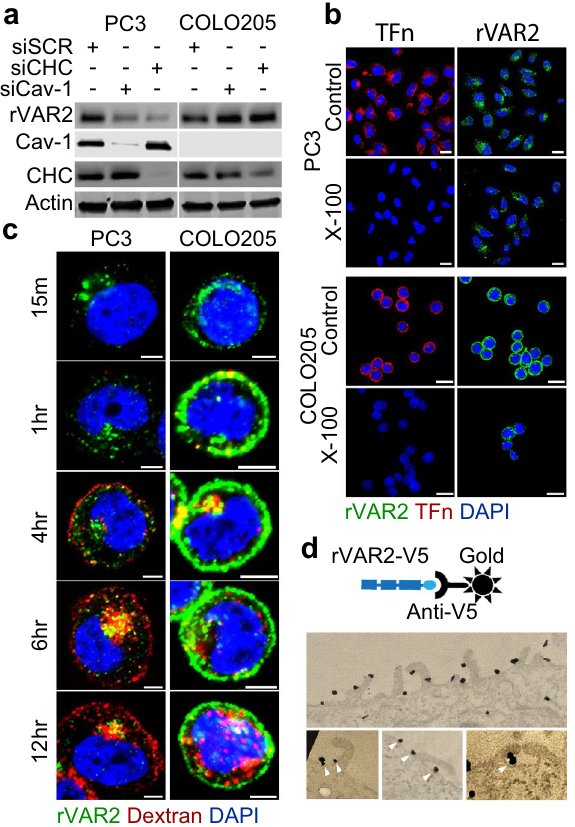
Figure 3. Endocytic mechanism of rVAR2. ( a ) Western blot for rVAR2, CHC, and Cav-1 in PC3 and COLO205 cells following transfection with siSCR, siCHC, or siCav-1. Actin was used as loading control. ( b ) Confocal images of rVAR2 in Triton X-100 treated PC3 and COLO205 cells, transferrin (TFn) was used as control for Triton X-100 treatment. Scale bar represents 10 µM. ( c ) Colocalization of rVAR-488 and Dextran-594 in COLO205 and PC3 cells at indicated timepoints. Scale bar represents 5 µM. ( d ) Electron microscopy of COLO205 cells treated with rVAR2. Gold-nanoparticle labeled antibodies was used to detect the presence of rVAR2. Arrowheads indicate the presence of rVAR2 binding near membrane protrusions that corresponds to structures formed during